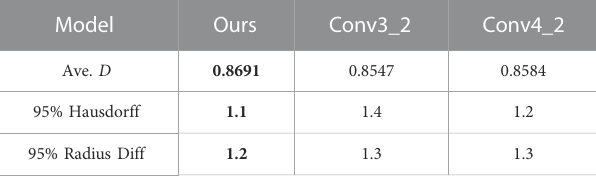
TABLE 7 Ave. D obtained when tree-structured ConvLSTM is inserted after different layers in the decoding stage. Model Ours Conv3_2 Conv4_2 Ave. D 0.8691 0.8547 0.8584